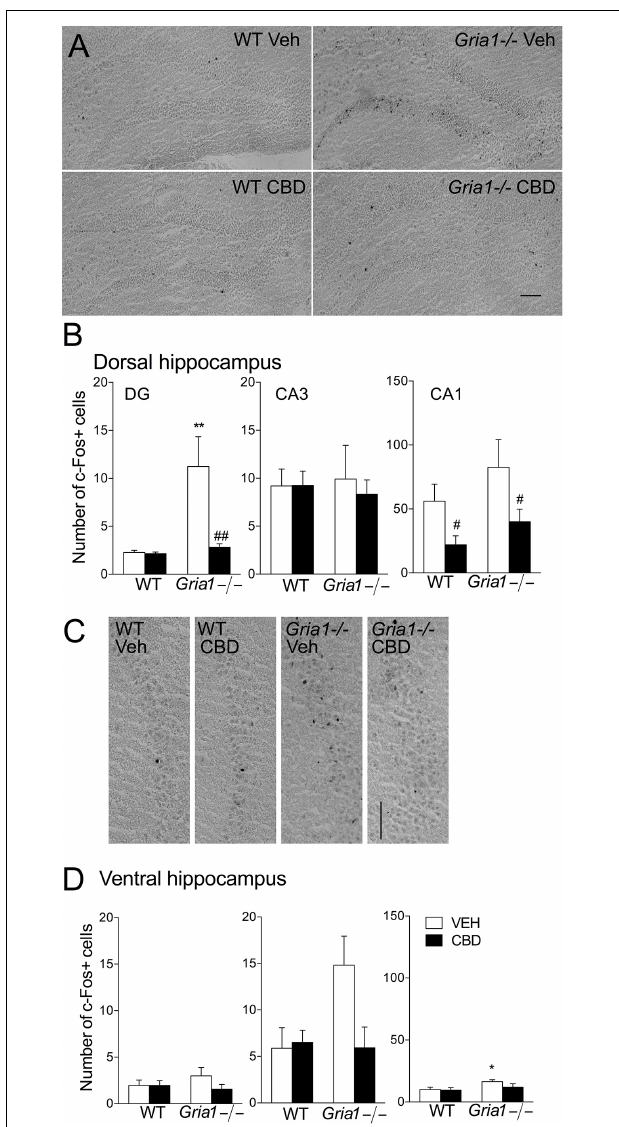
FIGURE 2 | Expression of c-Fos protein in hippocampal subregions of the Gria1 − / − and WT mice after a 2-h exposure to a novel environment with pre-treatment with vehicle or cannabidiol (15 mg/kg). (A) Representative images of the dorsal hippocampus. (B) Counts of c-Fos+ cells in the subregions of the dorsal hippocampus. Open bars for the vehicle- (VEH) treated and closed bars for cannabidiol- (CBD) treated groups. (C) Representative images of the ventral hippocampus. (D) Counts of c-Fos+ cells in the subregions of the ventral hippocampus. Means ± SEMs are shown for 4–6 mice per group. ∗ P < 0.5, ∗∗ P < 0.01 for the significances of the differences between genotypes after the same treatment, # P < 0.05, ## P < 0.01 for the difference from the vehicle within the same genotype (Bonferroni post-test). Scale bar: 100 µ